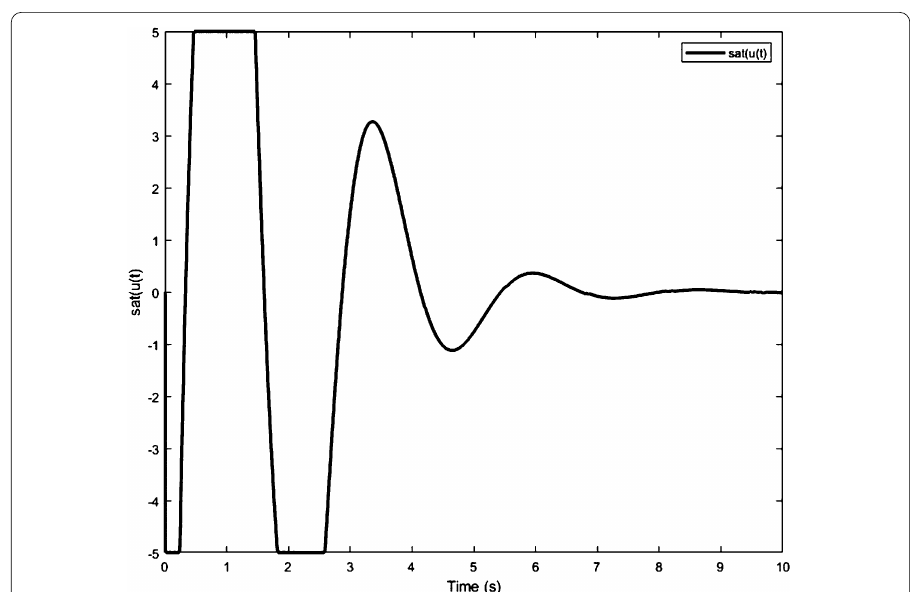
Figure 4 Time history of the saturated control input applied for the Arneodo system